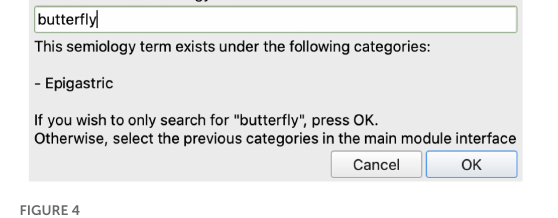
FIGURE4 Adding a custom semiology term to the semiology visualization module. For example, ‘butterflies’ and ‘déjà vu’ would be matched with epigastric and psychic auras, respectively. In this case, the term butterfly was entered as the patient described “a butterfly feeling in my stomach”. The module used to query the database matches the input term with the Epigastric semiology term, and therefore the 3D Slicer module suggests matching Epigastric to the list of selected